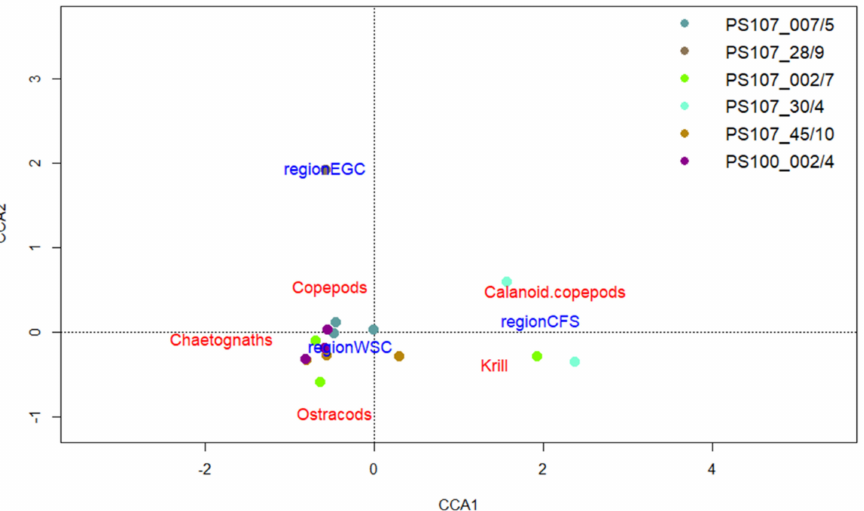
Figure 6. Canonical correspondence analyses (CCA) of the spatial variation of prey items for T. abyssorum . Colors indicate different stations; regions are identified by geographical region in- dicated in Figure 1. Only 50% of the most abundant prey species are displayed. The first axis (CCA1) separates the two Atlantic regions from each other, with the WSC region being located on the left-hand side. The second axis (CCA2) separates the EGC region from the other two geographical regions, with the EGC regions in the upper